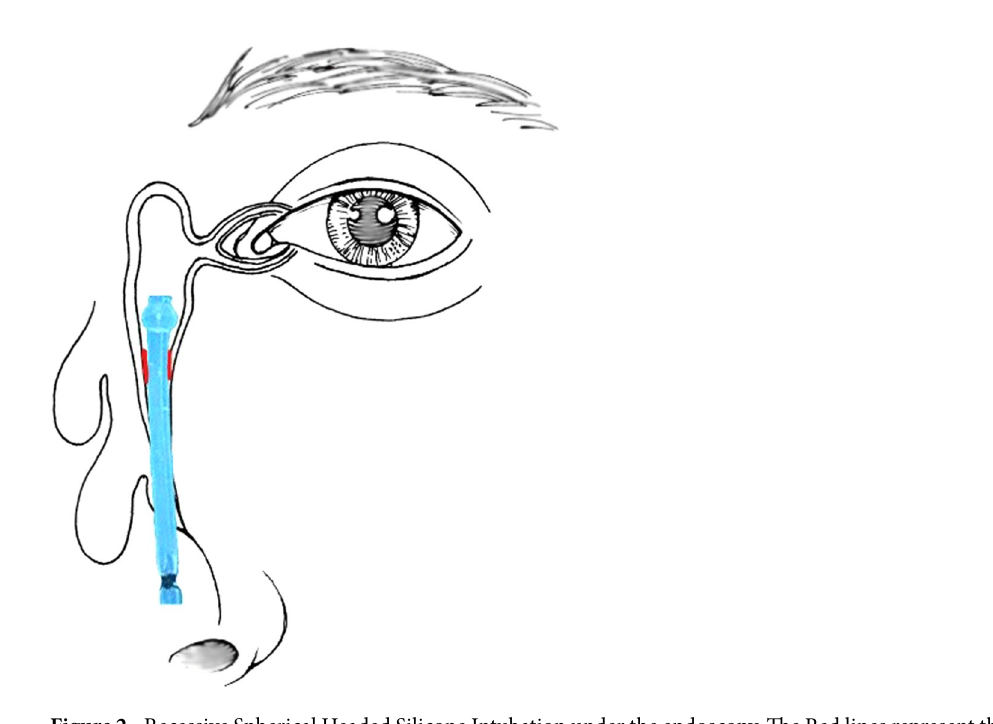
Figure 2. Recessive Spherical Headed Silicone Intubation under the endoscopy. The Red lines represent the obstruction in nasolacrimal duct. The Blue canaliculi represents the recessive spherical headed silicone tube (Drawn by